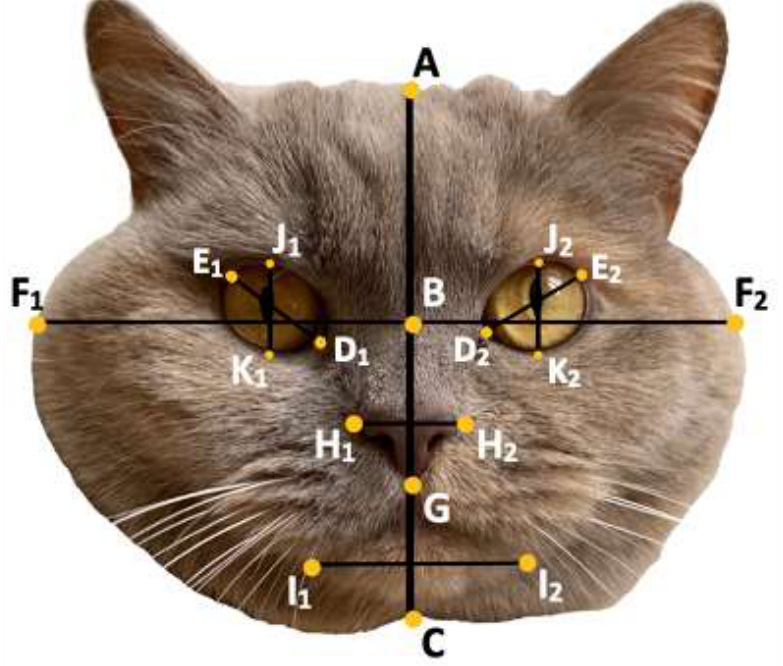
Figure 3. Glocker et al., (2009) Method. Face length (AC), forehead length (AB), face width (F 1 F 2 ), nose length (BG) and width (H 1 H 2 ), mouth width (I 1 I 2 ), eye width (average of D 1 E 1 and D 2 E 2 ) and height (average of J 1 K 1 and J 2 K 2 ).